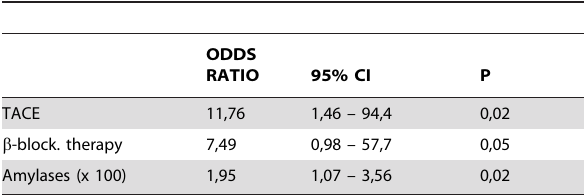
Table 3. Risk of pre-LT aneurisms among cirrhotics waiting fort LT